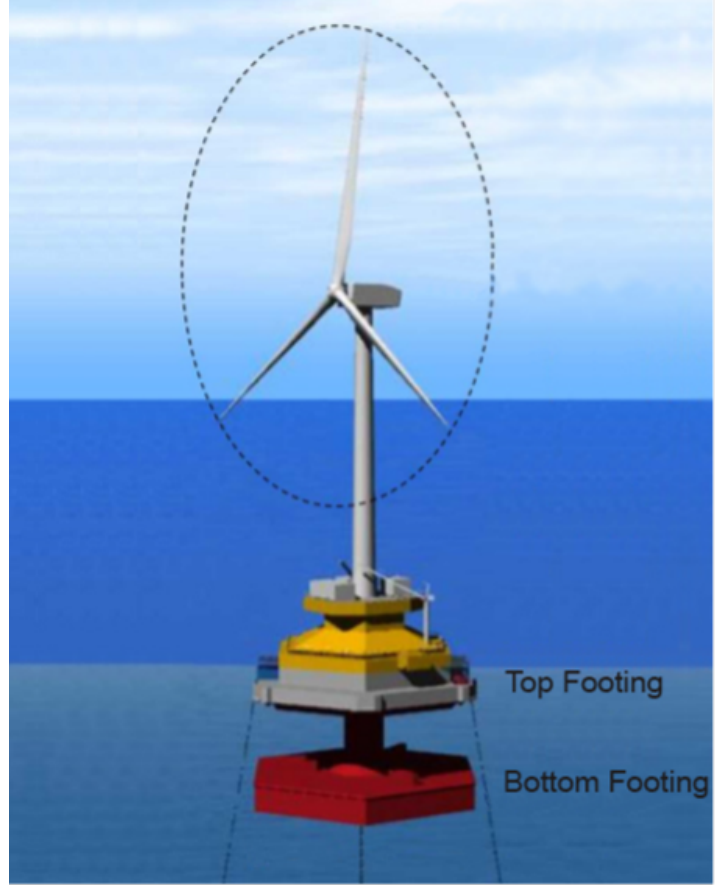
Figure 1. The conceptual idea of the Advanced Spar